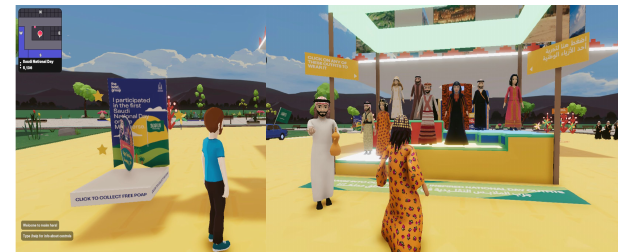
Figure 8: BBA president, Prof Naseem Naqvi, in his digital avatar, visiting Saudi Arabia’s National Day in the Decentraland Metaverse